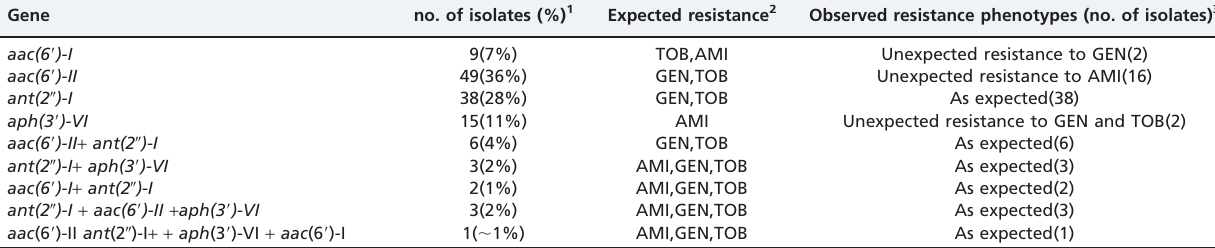
Table 2 - Prevalence of aminoglycoside modifying enzymes genes and the correlation between these genes and phenotypic patterns in aminoglycoside resistant P. aeruginosa isolates.